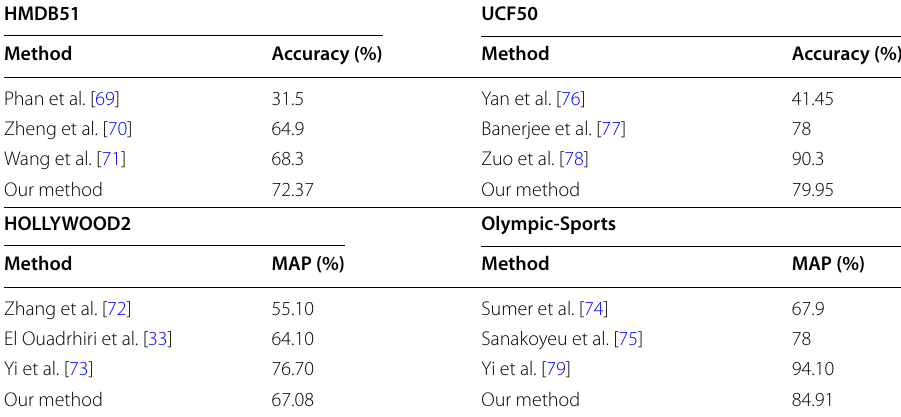
Table 2 Performance comparison of our results to the state of art HMDB51